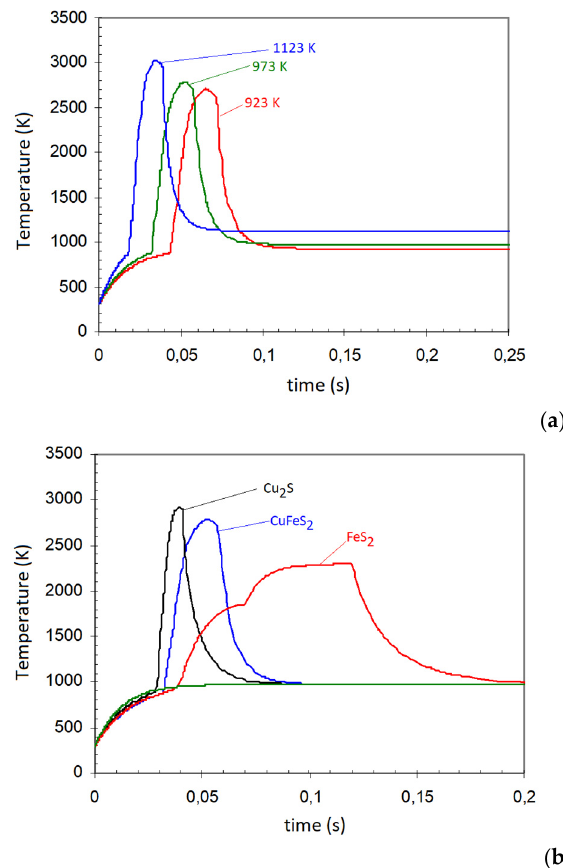
Figure 3. Temperature evolution for CuFeS 2 (chalcopyrite) and different minerals species for particle size of 27 µ m and pO 2(g) = 0.8. ( a ) Chalcopyrite at different Temperature of the environment ( b ) T environment 973 K and size of particle = 27 µ m.